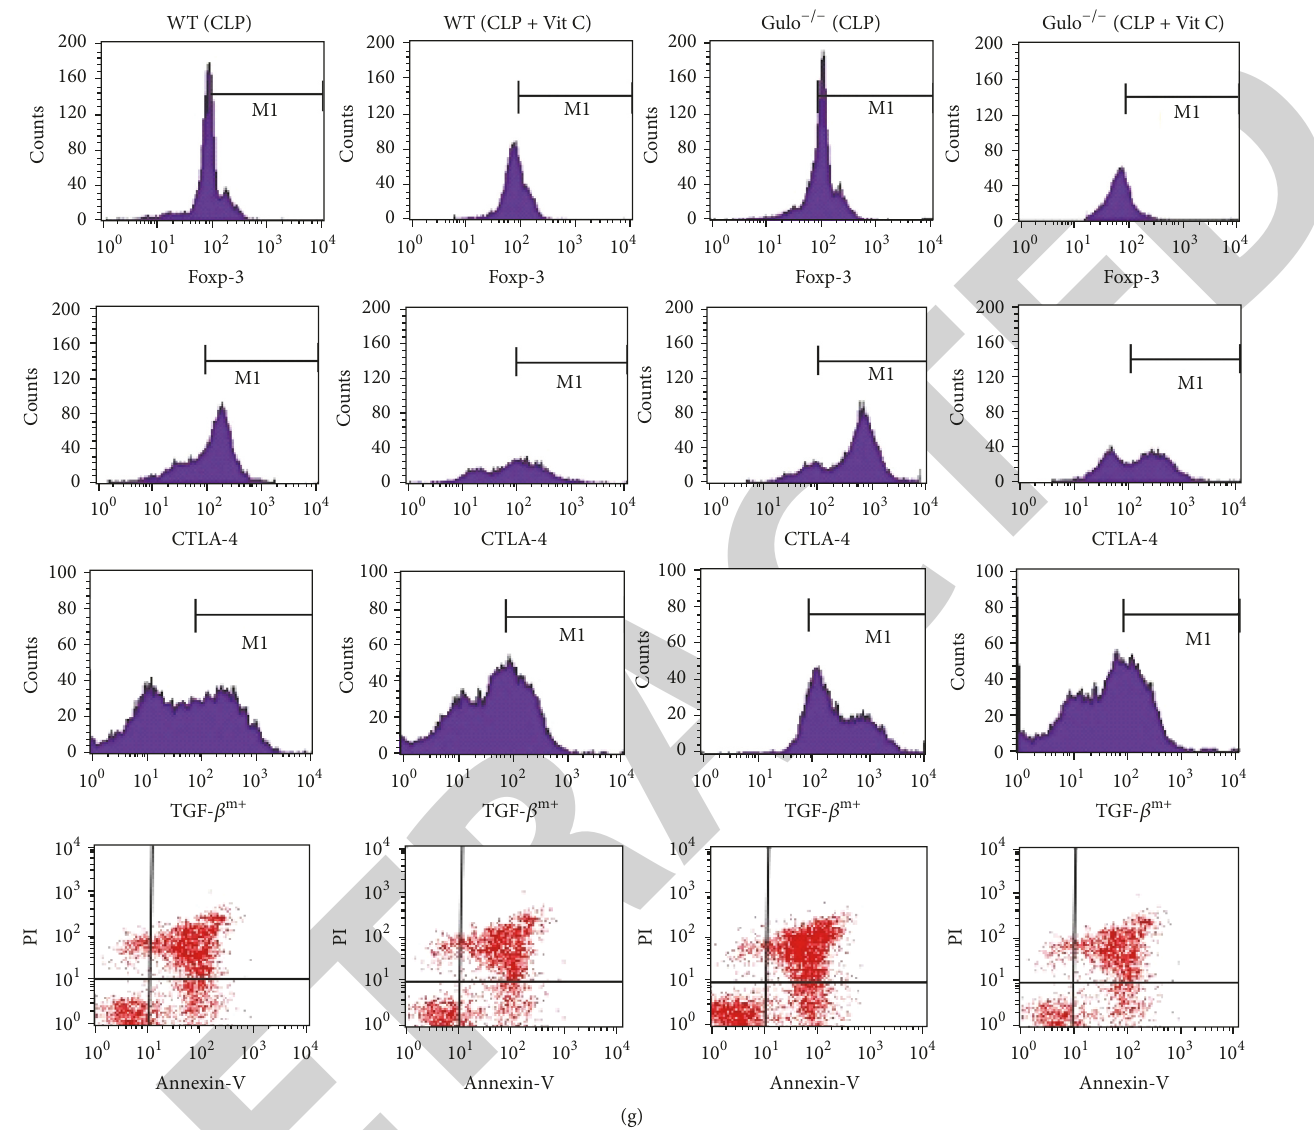
Figure2:ParenteralVitCmarkedlyweakenedthestabilityofCD4 + CD25 + Tregsinsepsis.TheexpressionsofFoxp-3,CTLA-4,andTGF- 𝛽 m +